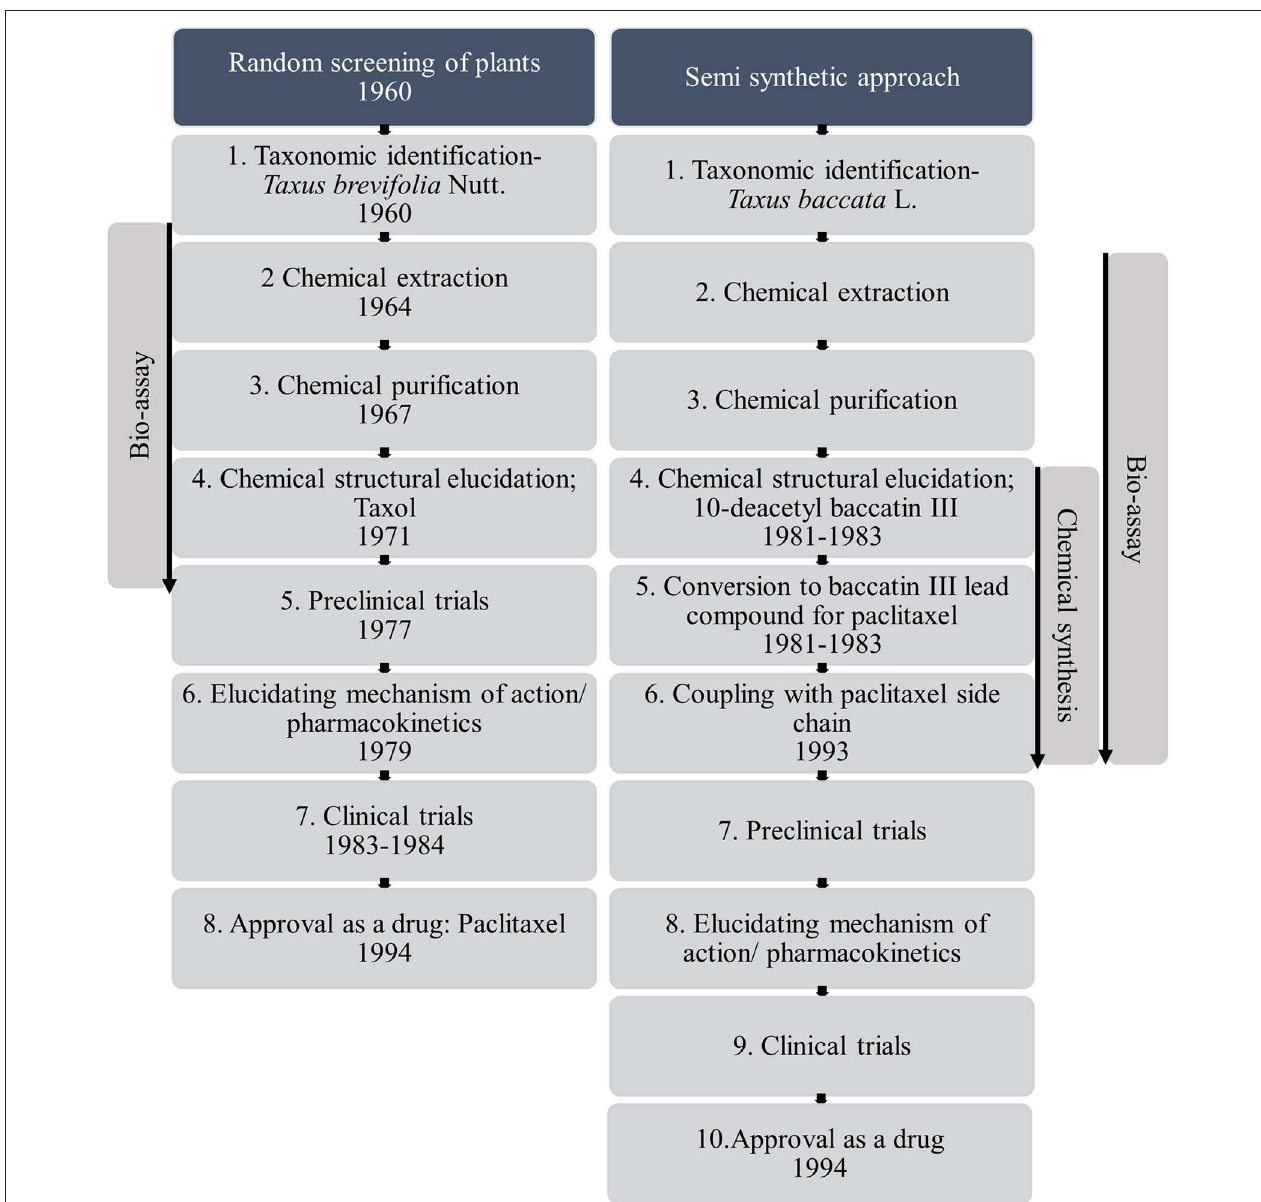
FIGURE 1 | Conventional pathway from random screening to novel drugs, using Taxus brevifolia Nutt. and alternative partially synthetic pathway from Taxus baccata L. as example species, a process which took over 30 years (based on information from Wani et al., 1971; Holton et al., 1994; Wall and Wani, 1995; Baloglu